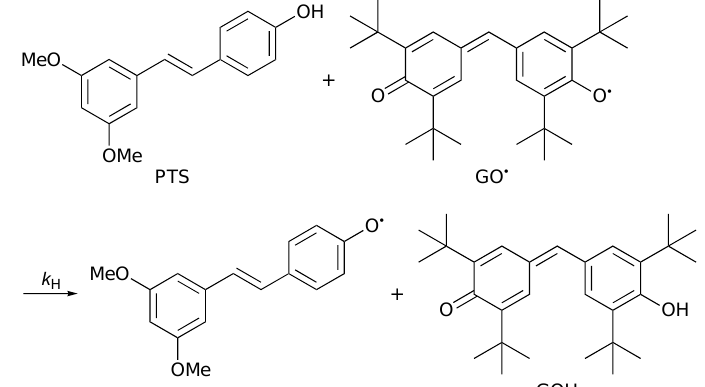
Figure 3. Hydrogen transfer from PTS to GO • .